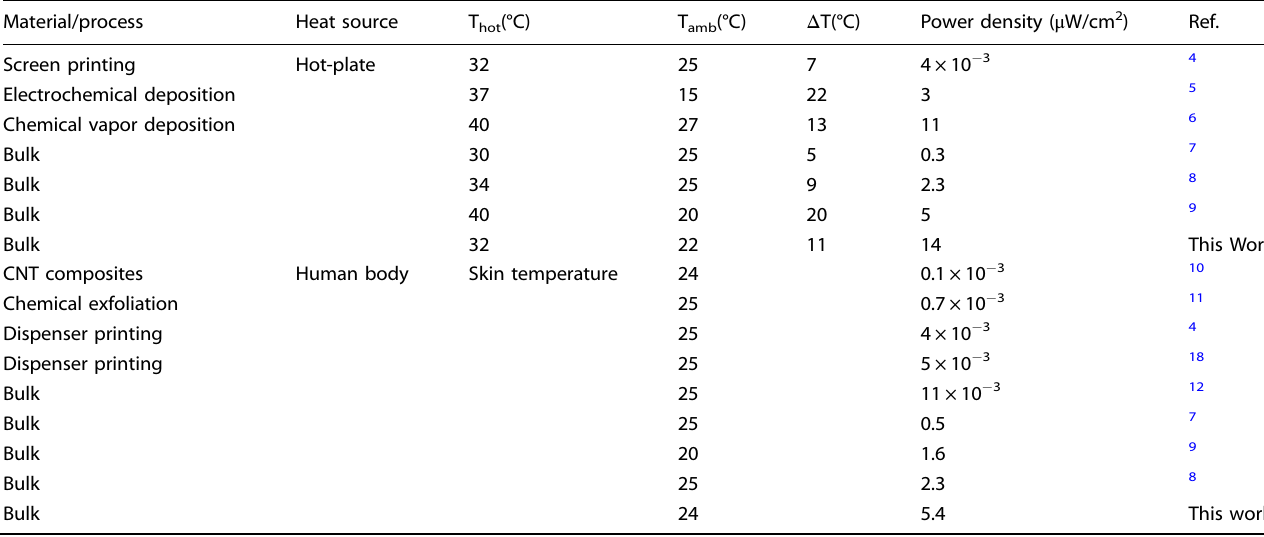
Table 1. Power density levels reported for different fl exible TEGs measured without any air fl ow.